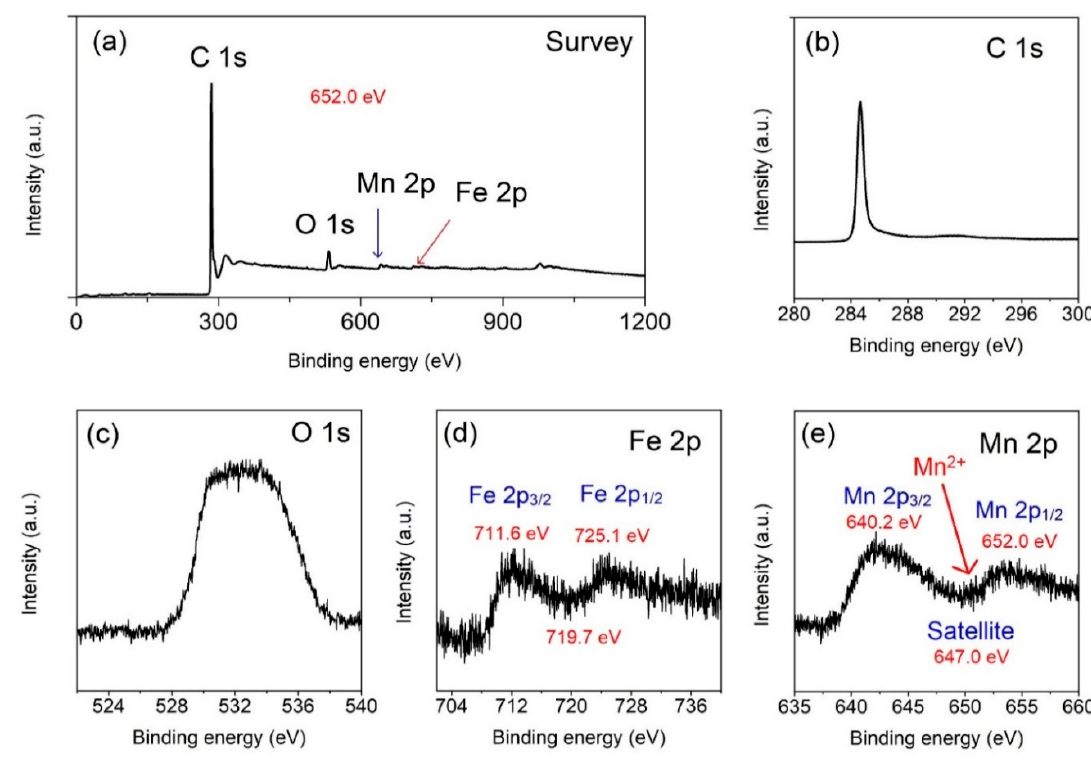
Figure 5. XPS spectra of EG@MnFe 2 O 4 : ( a ) Survey, ( b ) C 1s, ( c ) O 1s, ( d ) Fe 2p, ( e ) Mn 2p.